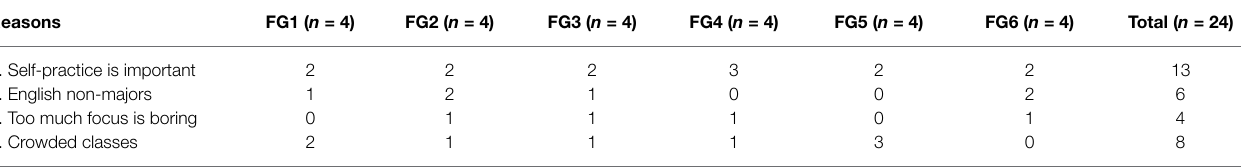
TABLE 1 | Students’ reasons for their suggested pronunciation teaching